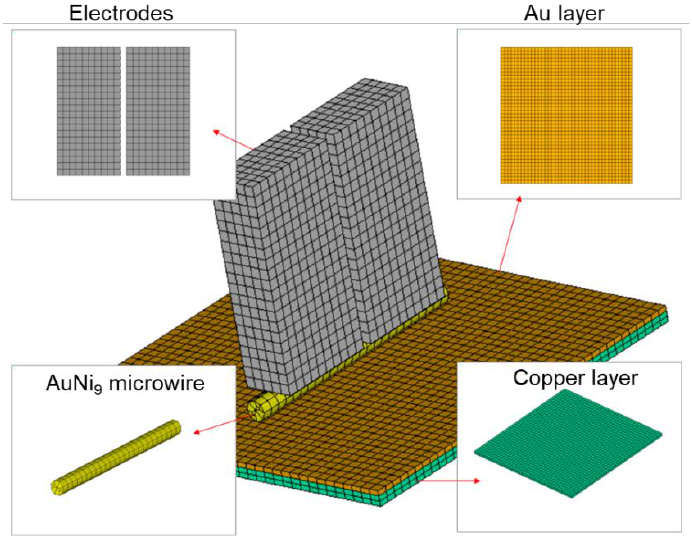
Figure 3. Finite element model of the welding structure.